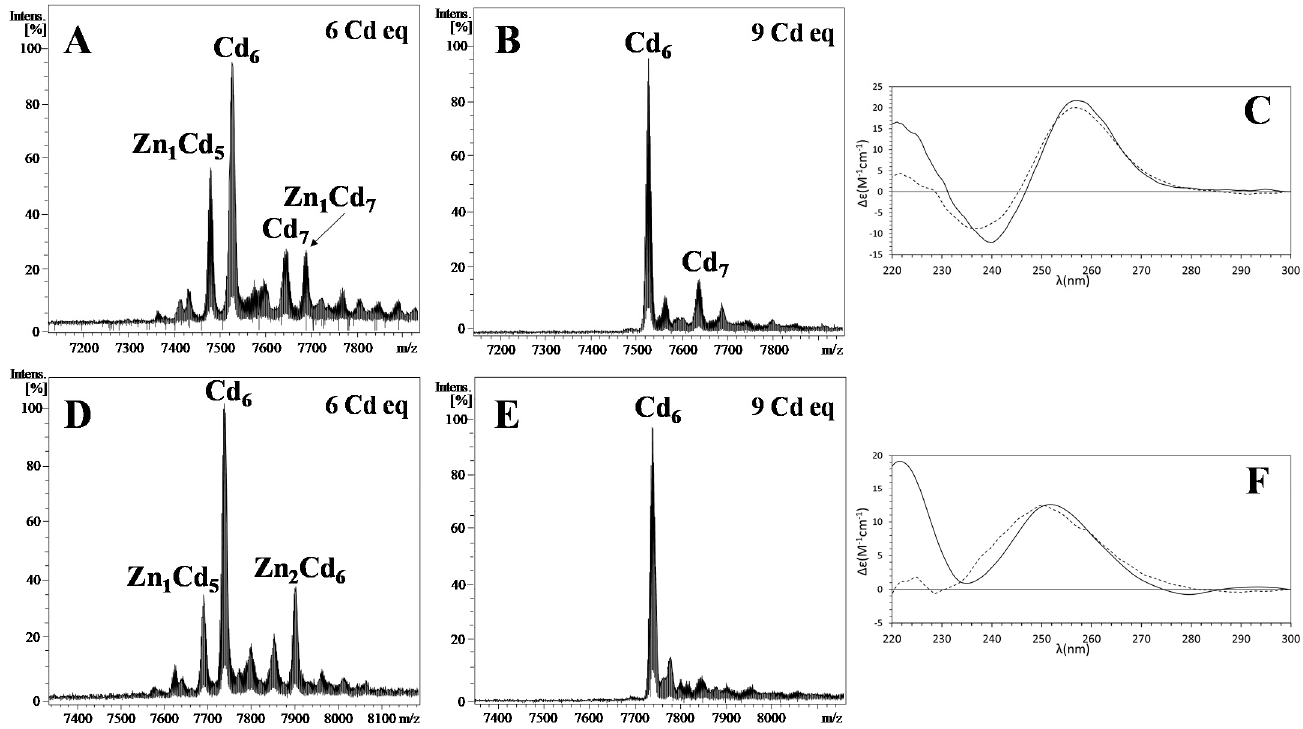
Figure 4. Deconvoluted ESI-MS (pH 7.0) spectra of ( A ) Zn-NpeMT1 + 6 Cd II eq, ( B ) Zn-NpeMT1 + 9 Cd II eq, ( D ) Zn- NpeMT2 + 6 Cd II eq, ( E ) Zn-NpeMT2 + 9 Cd II eq. ( C ) CD spectra of Cd-NpeMT1 (solid) and Zn-NpeMT1 + 9 Cd II eq (dashed). ( F ) CD spectra of Cd-NpeMT2 (solid) and Zn-NpeMT2 + 9 Cd II eq (dashed).